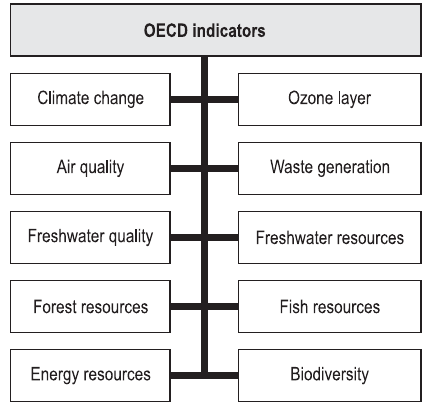
Fig. 5. Organisation’s for Economic Co-operation